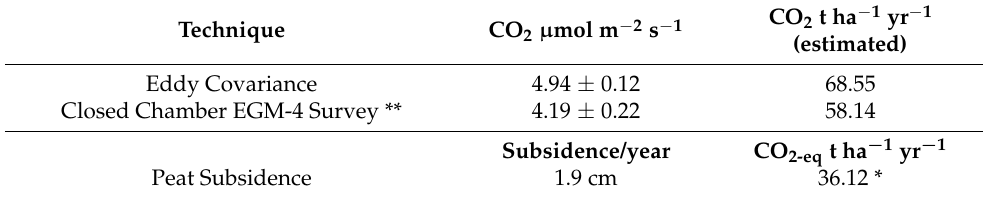
Figure 9. Mean CO 2 flux with error bars was measured using the eddy covariance, soil chamber, and peat subsidence methods at the 1 ha site. Table 2. Peat CO 2 emissions measured at the site.